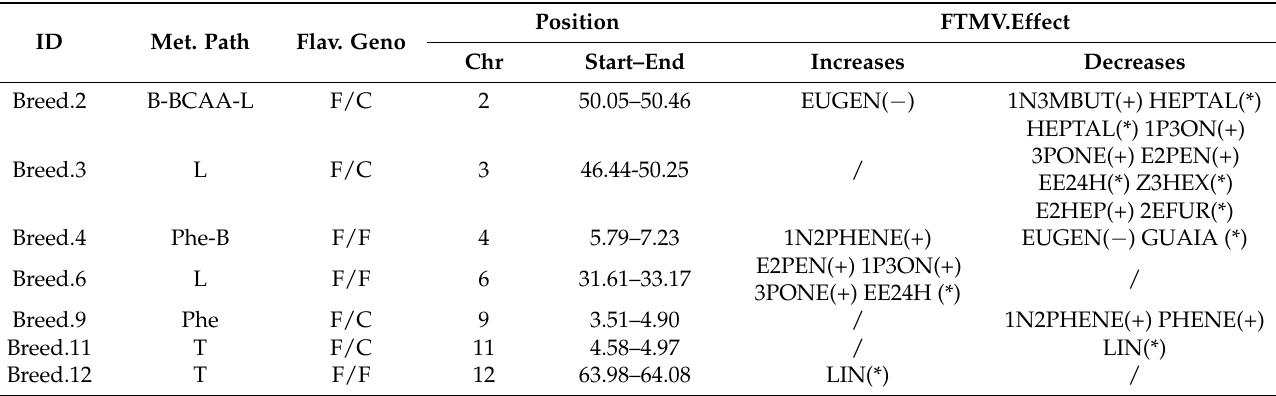
Table 4. Candidate regions for flavour